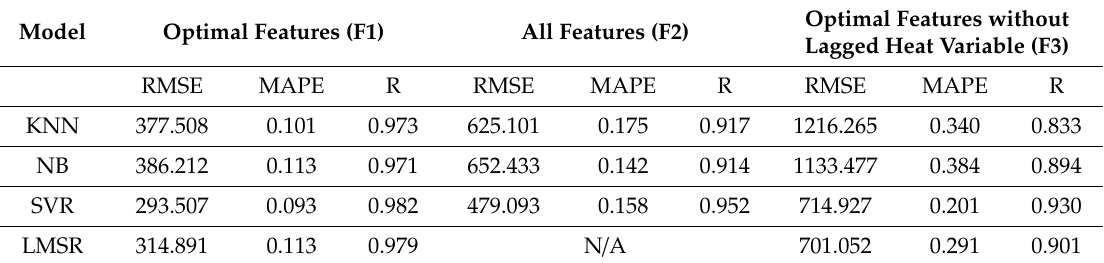
Table 4. Heat modelling results from 2015 Apr–2017